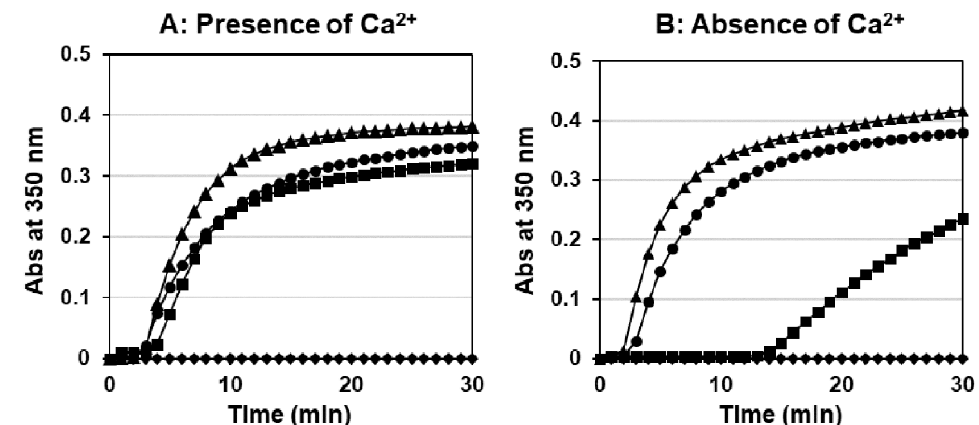
Figure 5. Thrombin catalyzed fibrin polymerization. The polymerization of 0.18 mg/mL recombinant fibrinogens was initiated with 0.05 U/mL thrombin in the presence of 1 mM Ca 2+ ( A ) or absence of Ca 2+ ( B ). • : Wild-type, (cid:7) : γ R275C, (cid:78) : γ T277R, (cid:4) : γ Y278H.